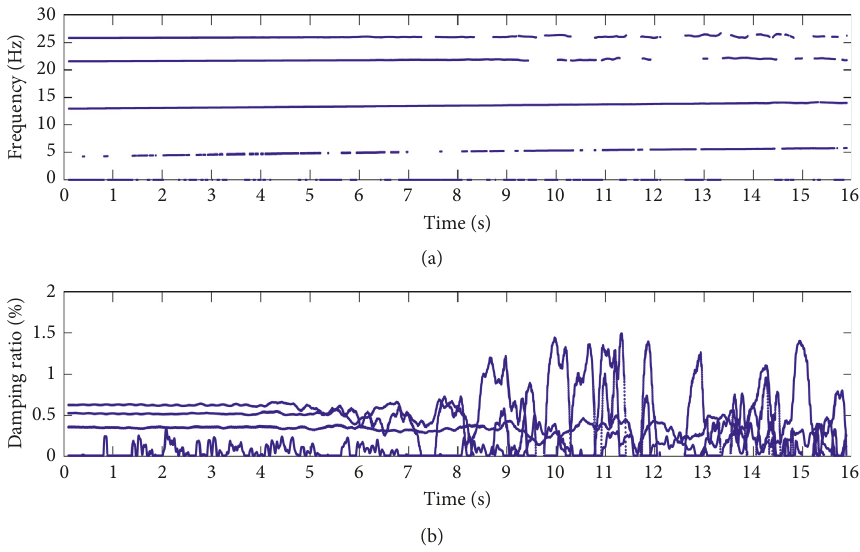
Figure 7: Frequency ( f ∼ f ∼ ξ 1 4 ) and damping ratio ( ξ 1 4 ) identification results of simulation case 2 (SNR (cid:29) 40dB): identification results for (a) natural frequencies and (b) damping